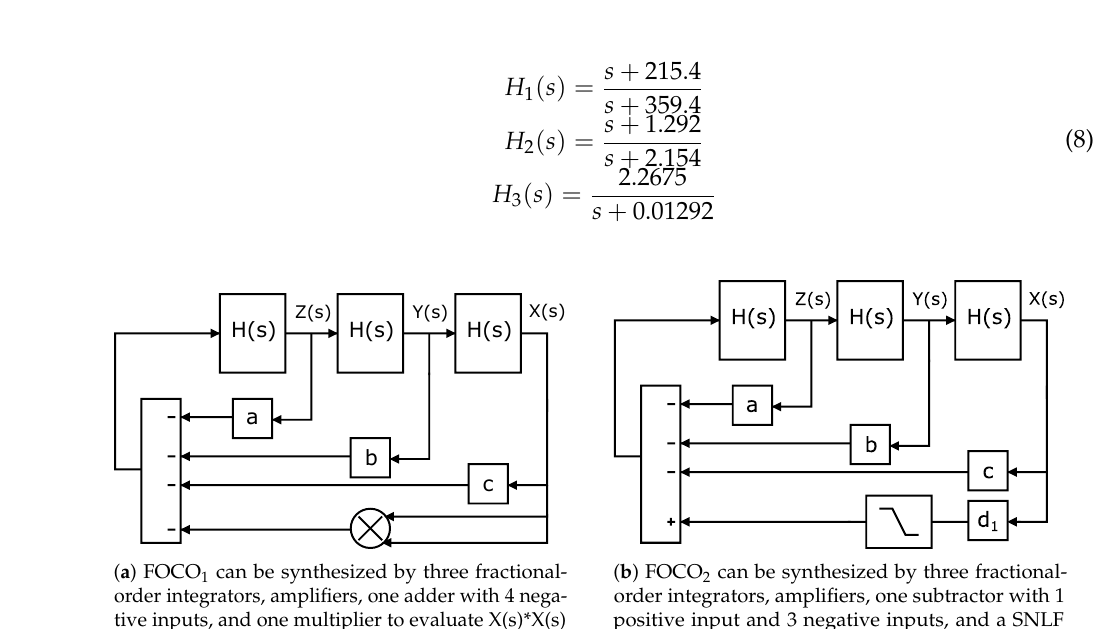
Figure 3. Block diagrams of the FOCOs, where H ( s ) = 1/ s 0.9 .